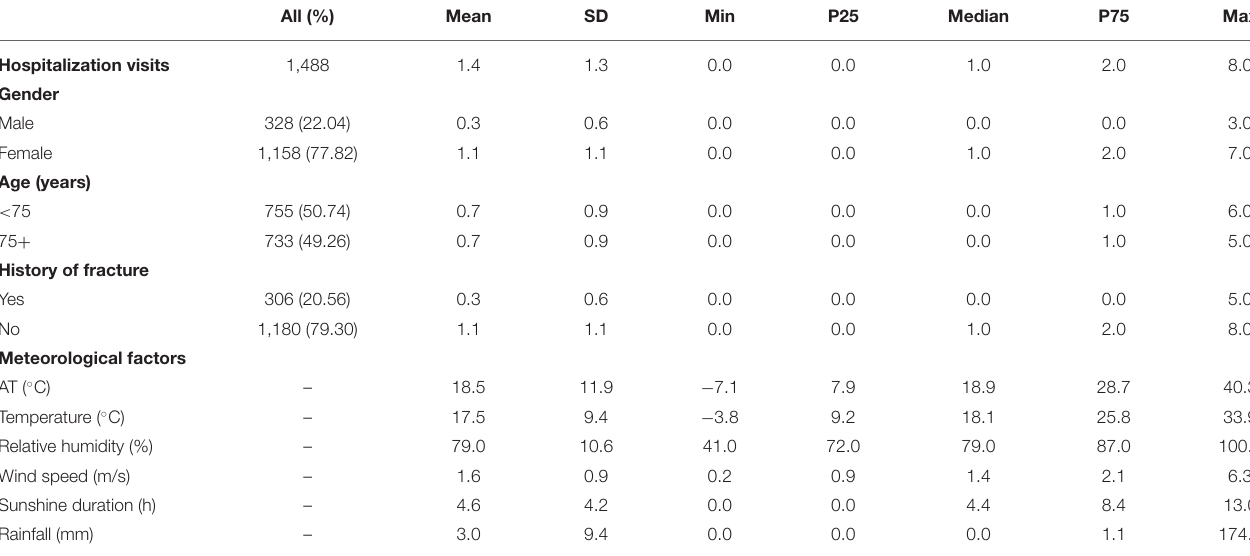
TABLE 1 | The descriptions of hospitalizations for osteoporotic fracture and meteorological factors.